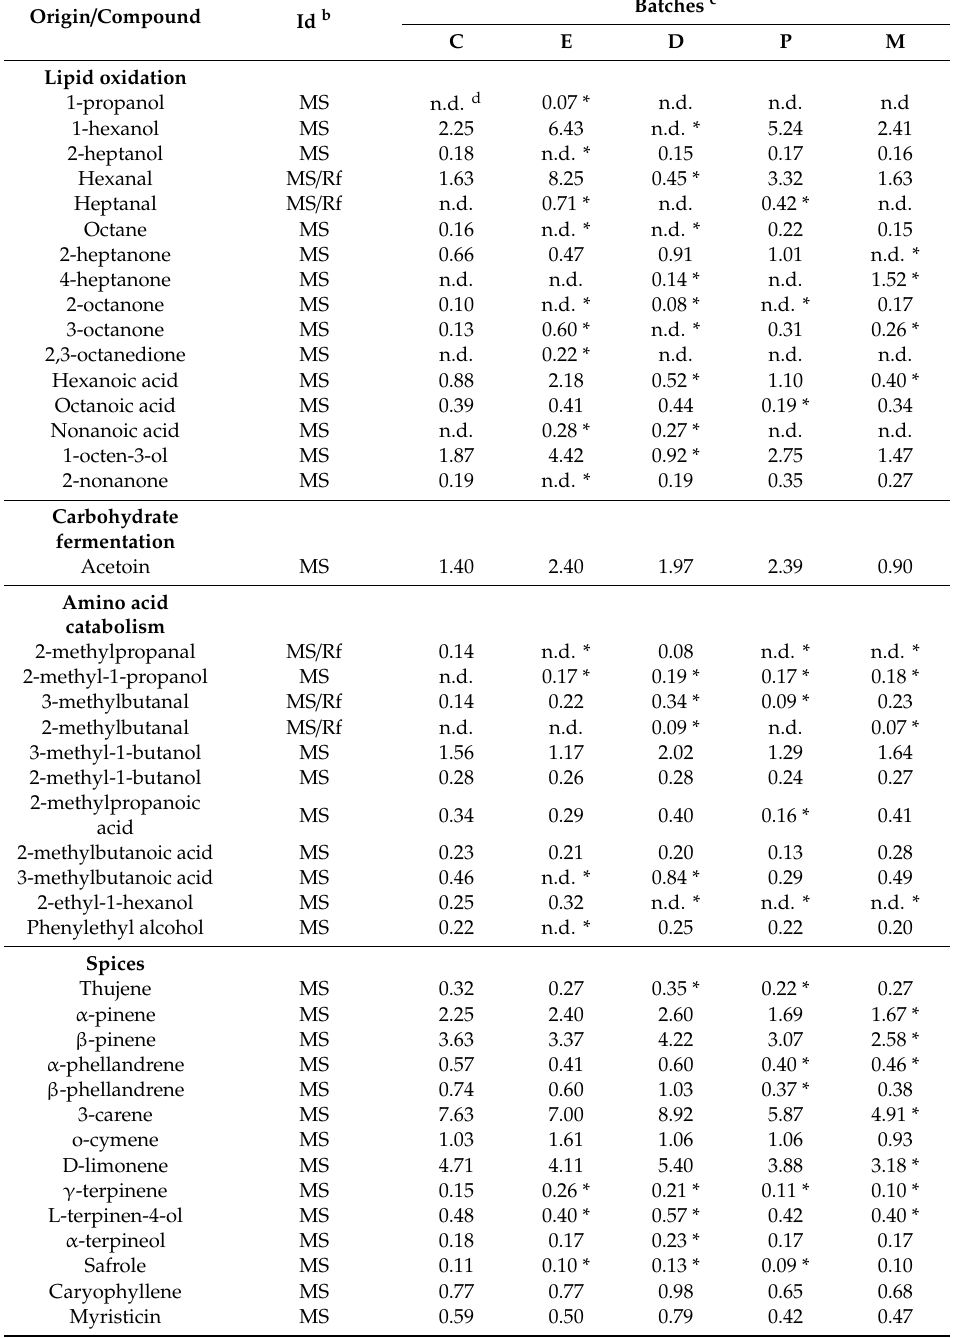
Table 2. Volatile compounds a identified and quantified from dry-cured fermented sausages (salchich ó n) inoculated with biocontrol agents after 21 days of